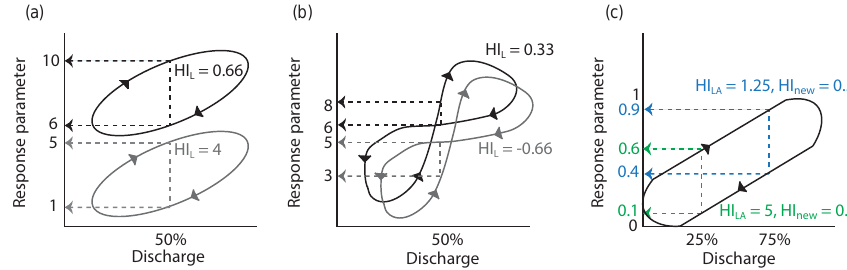
Figure 1. (a) Impact of storm initial concentration, (b) storm initial discharge on the value of the calculated HI when the mid-point in discharge and raw data is used and (c) an idealised and normalised storm illustrating the impact of measuring different quantiles of flow on the HI calculated, where HI L and HI LA are the original and adapted Lawler et al. (2006) methods, respectively and HI new , the proposed new method. Colours represent different discharge intervals